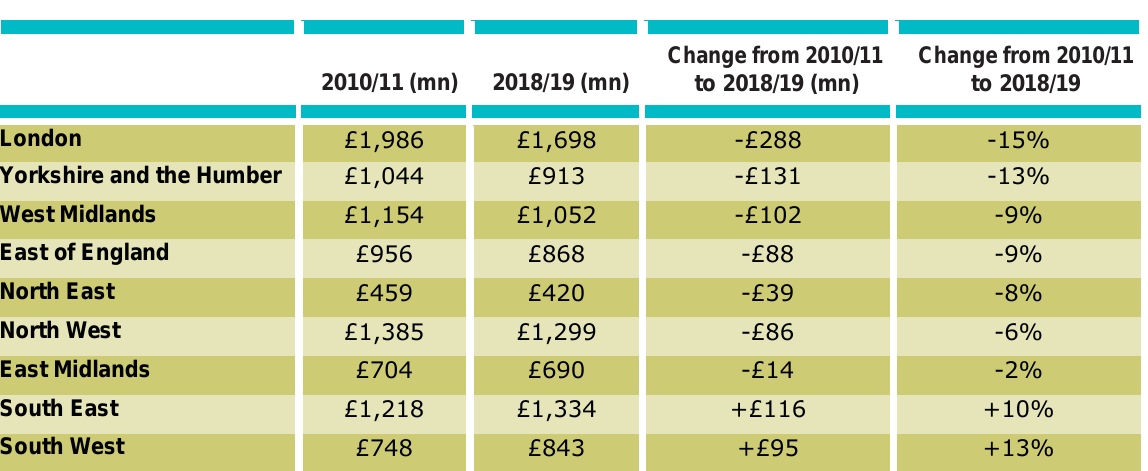
Table 3: Regional spending on children and young people’s services in real terms 22